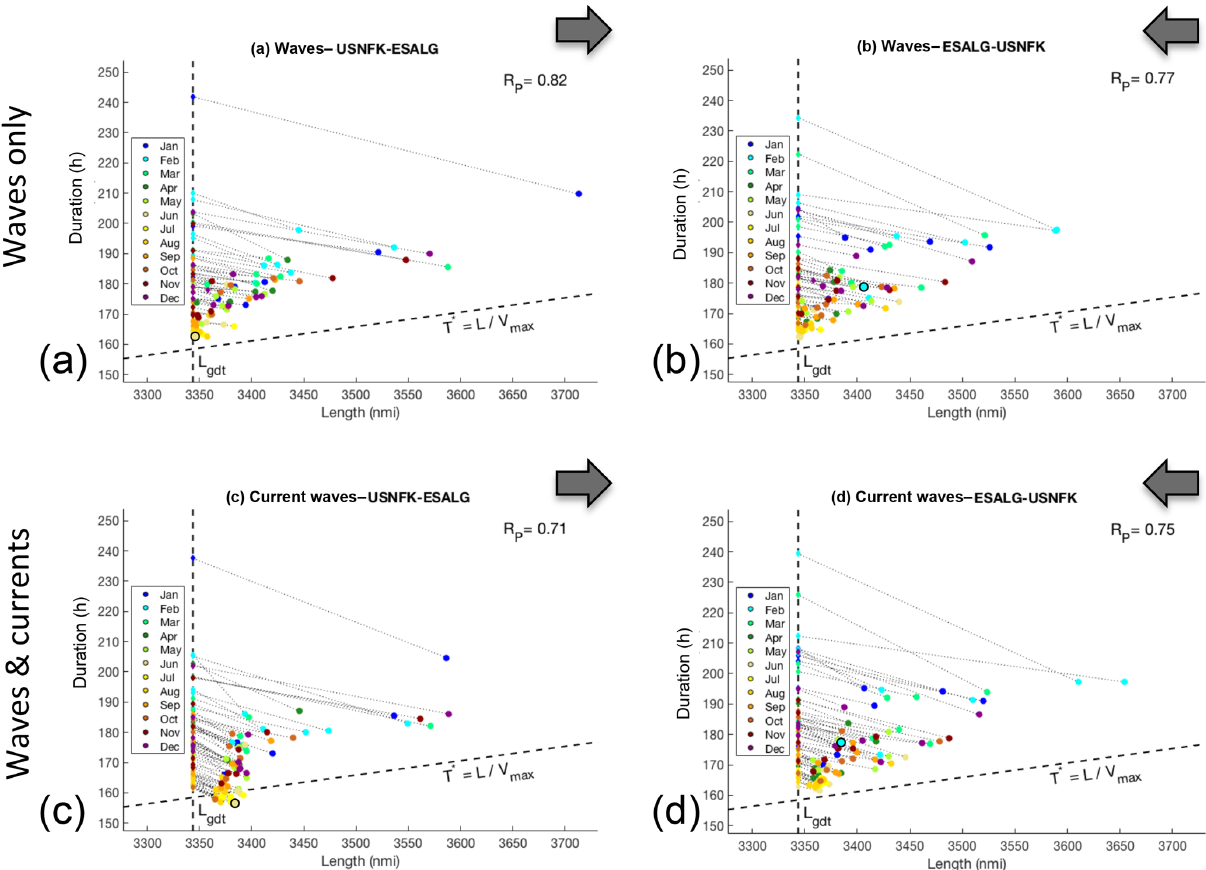
Figure 9. Distribution of optimal sailing time T ∗ vs. length L of the tracks of Fig. 7. For the geodetic tracks, L = L gdt is a constant. Corresponding optimal track dots ( L,T ∗ ) are joined by a light dotted line. The slanted dashed line has a slope V − 1 max . Tracks for w-type (a, b) and cw-type optimisation (c, d) , and for both east- and westbound directions, are displayed. Dots of the tracks analysed in Sect. 4.3 are outlined in black. Pearson’s correlation coefficient R P between T ∗ and L is printed in the top right corner of each